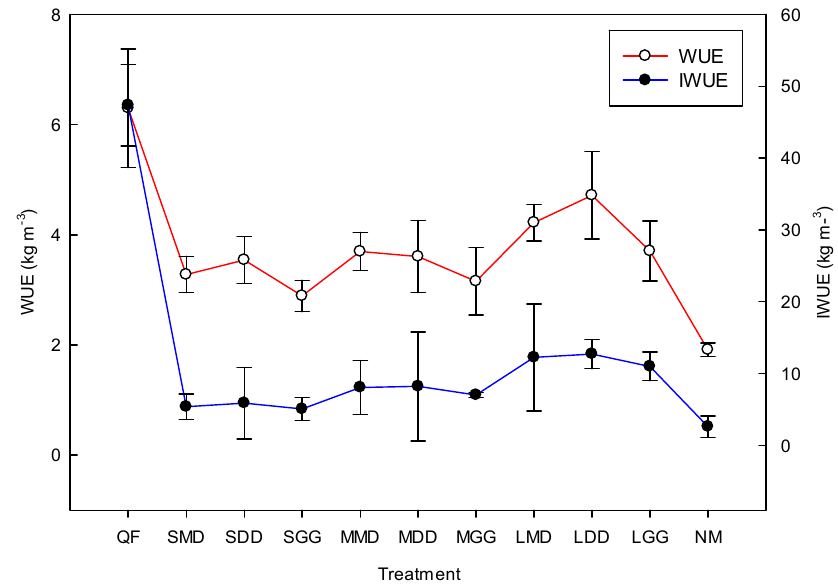
Figure 7. Trends of WUE and IWUE. Vertical bars indicate standard errors of means.